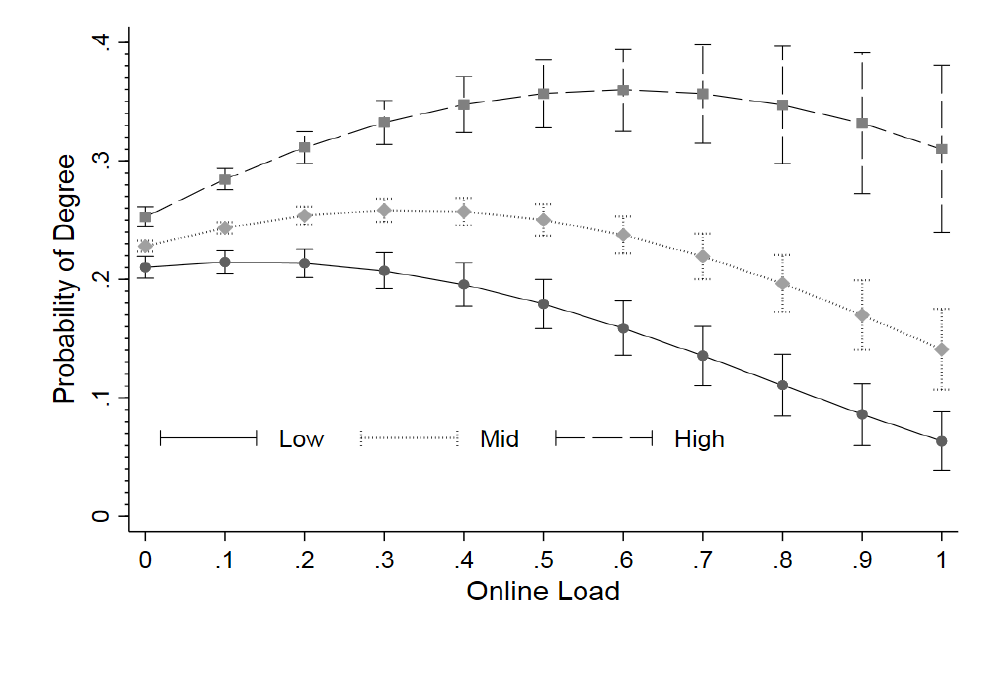
Figure 2 . Interaction between online load and overall institutional graduation